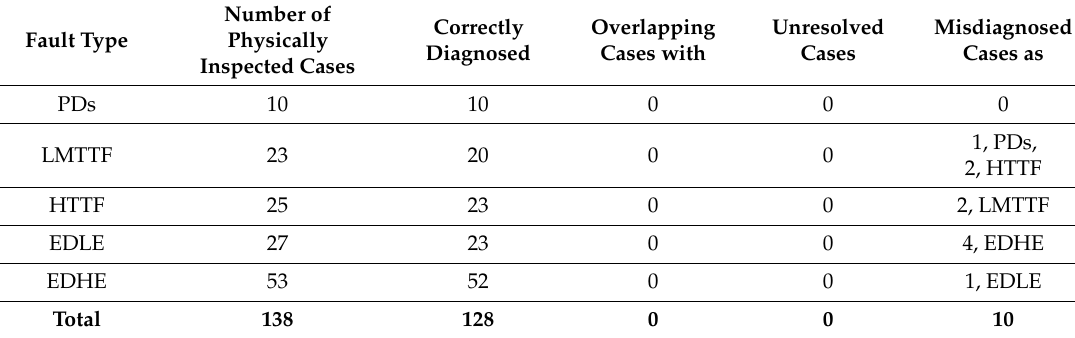
Table 9. Identification of faults using fuzzy-evidential